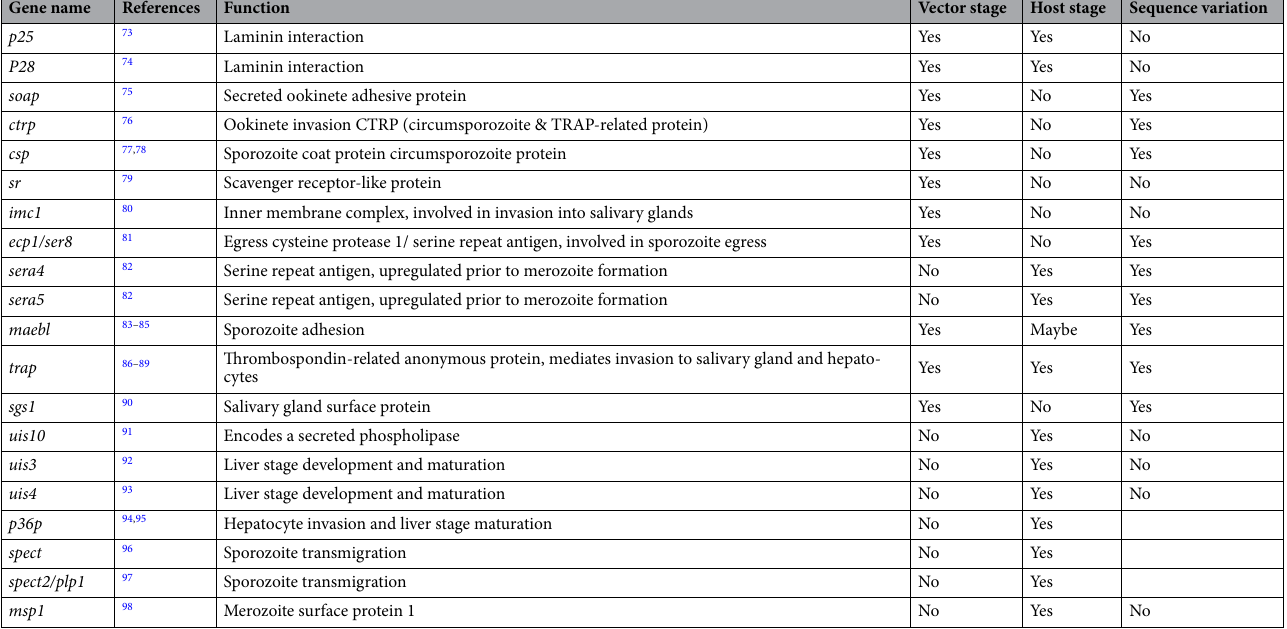
Table 2. Comparative analysis of genes related to vertebrate host and vector invasion. A list of 20 genes related to vertebrate host and vector invasion were obtained through literature searches. For each gene, its gene name, literature reference, function, and whether the gene product functions during the vector and/or host stage of the parasite’s life cycle are described. The final column lists whether the protein sequences from P. malariae and P. brasilianum accessions vary between the two species or not, or if there were not sufficient accessions to evaluate using multiple sequence alignment